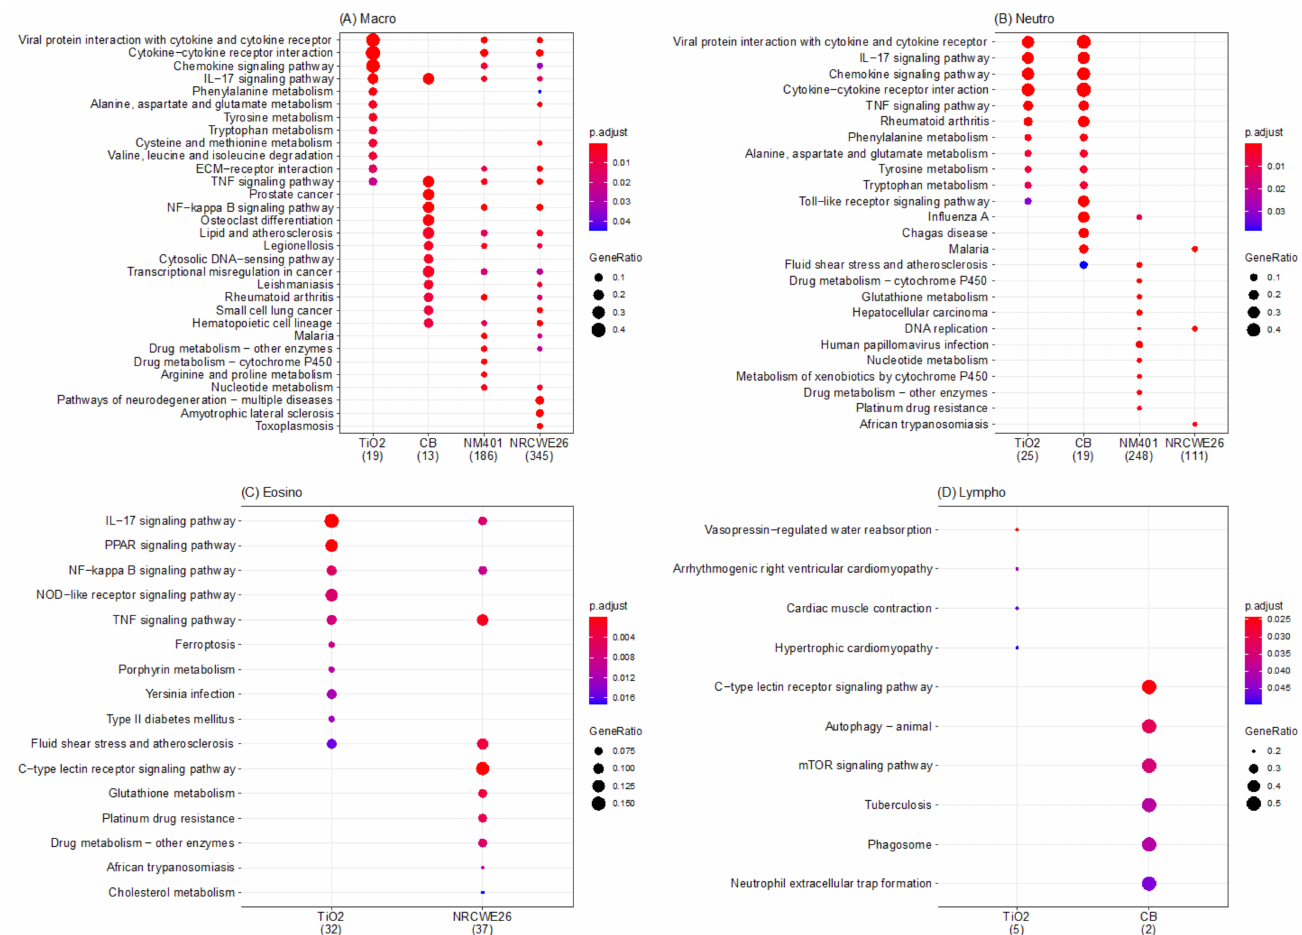
Figure 4. KEGG pathways of the dynamic dose-dependent genes for the different ENMs. The different panels represent the pathways enriched by the dose-dependent genes that for each ENM correlate with macrophages ( A ), neutrophils ( B ), eosinophils ( C ), and lymphocytes ( D ). The size of the dots represent the gene ration whereas the color represent the adjusted p -values of the enrichment analysis. The numbers in brackets below the ENM names represent the number of genes correlated with the cell